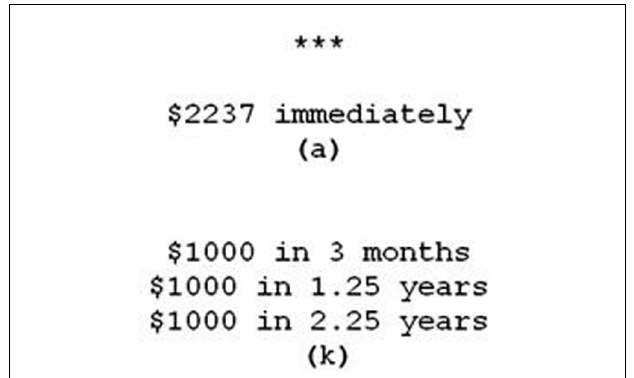
FIGURE 1 | An example display of a choice as seen by